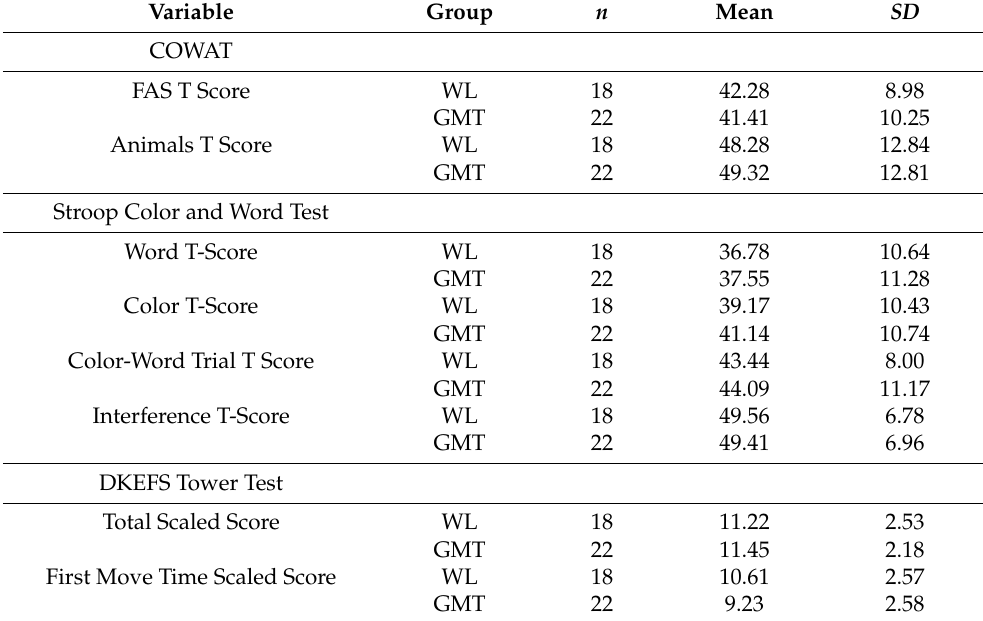
Table 2. Means and SDs for baseline neuropsychological assessment performance between WL and